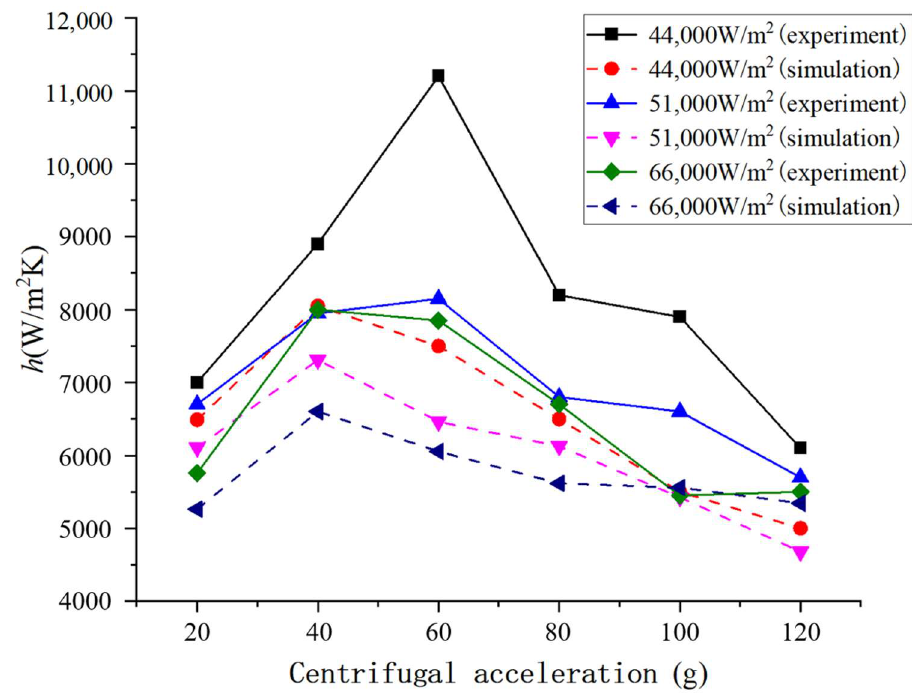
Figure 11. The variation of heat transfer coefficient with the centrifugal acceleration.